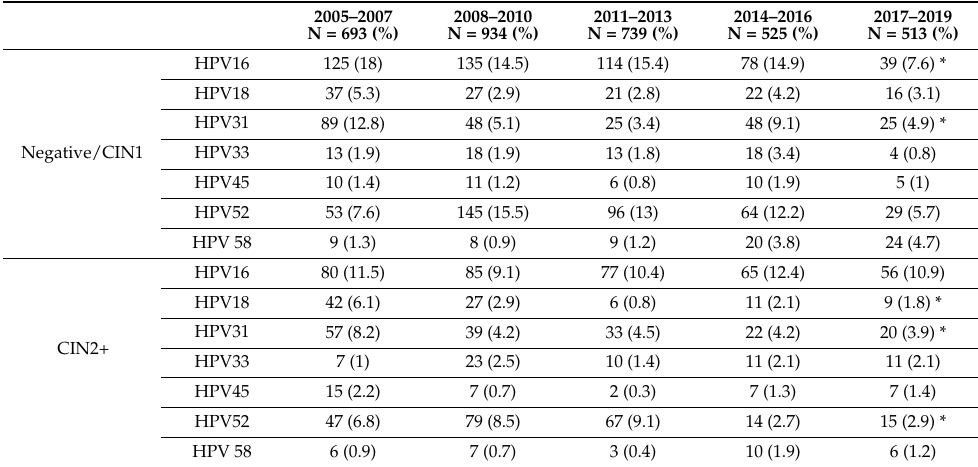
Table 3. Association between cytological findings et enrolment and HR-HPV genotypes contained in Nonavalent vaccine in five periods under